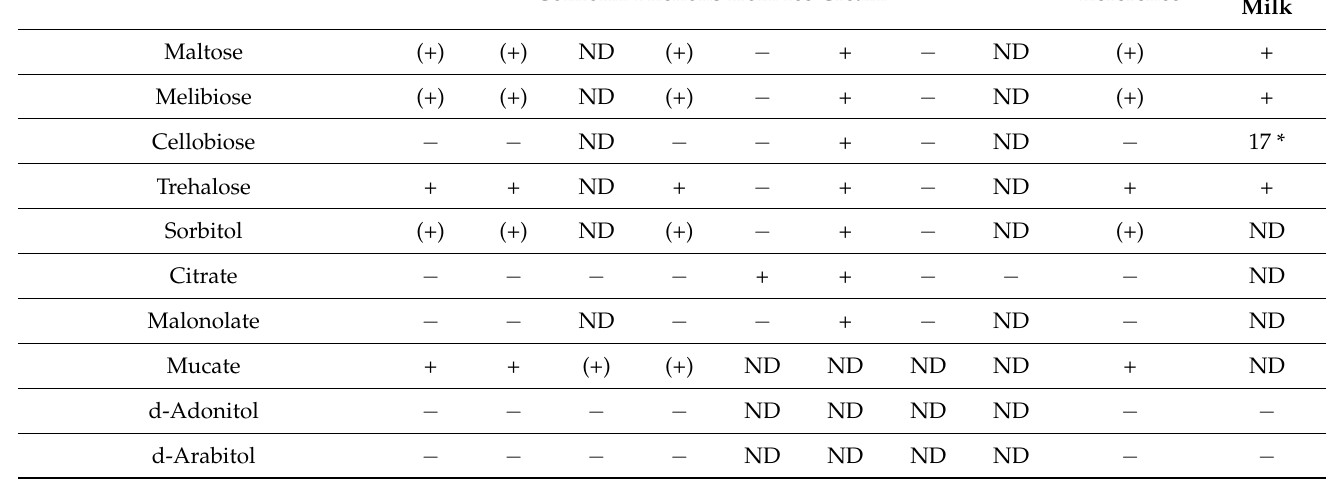
Table 2. Cont. Coliform Phenons from Ice Cream A